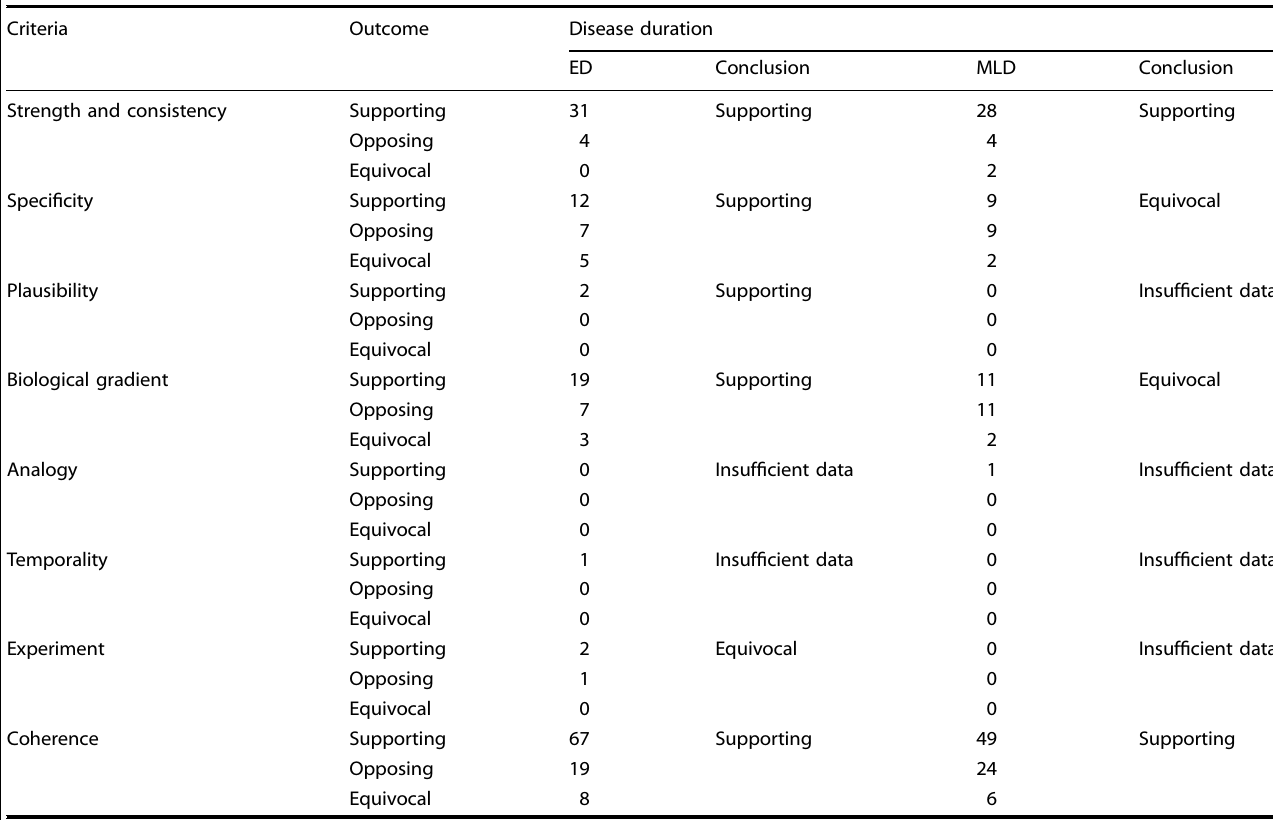
Table 2. Bradford Hill analysis of studies investigating iron dysregulation in Parkinson ’ s disease after strati fi cation according to disease duration.